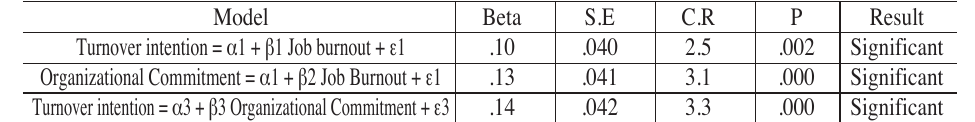
Organizational Commitment Mediates b/w Job Burnout and Turnover